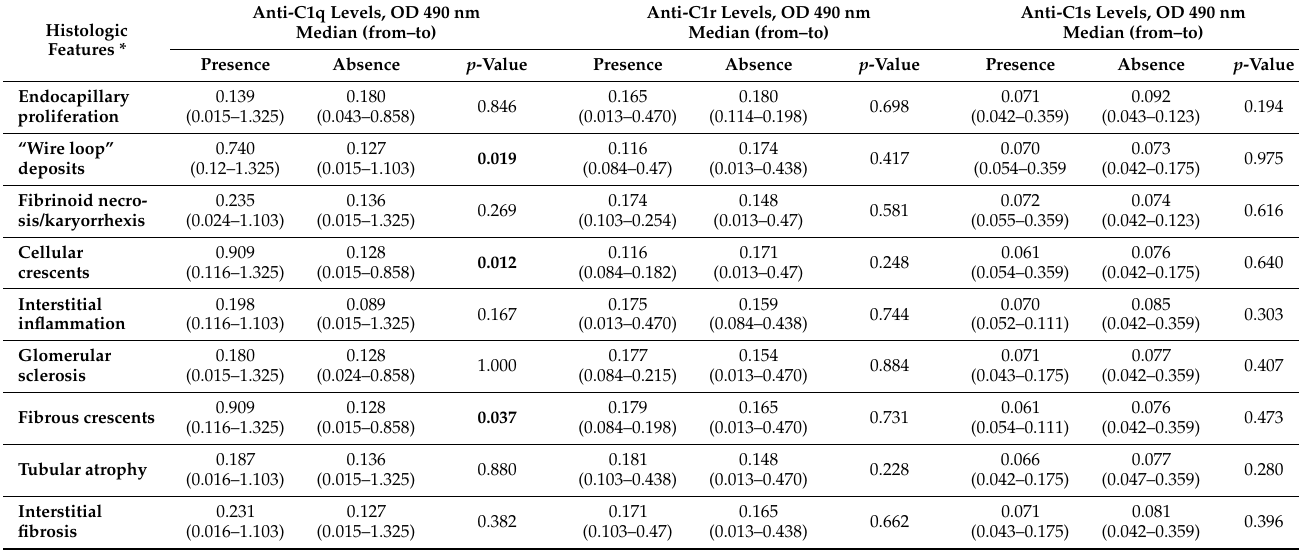
Figure 5. Association of the presence of anti-C1q antibodies in patients at the time of first sampling with the categories of the BILAG Renal score and histological signs of LN. Correlation between anti- C1q antibodies and categories of LN activity according to the BILAG Renal score ( A ). Comparative analysis between levels of anti-C1q antibodies in category A LN patients and patients classified into other categories according to the BILAG Renal score ( B ). ROC curve for anti-C1q antibodies in LN patients in BILAG category A towards LN patients in the rest of BILAG categories ( C ). Association between anti-C1q antibodies and histology class of LN ( D ). Correlation analysis between levels of anti-C1q antibodies and histological activity index ( E ) and histological chronicity index ( F ). Table 1. Comparative analysis between levels of anti-C1q, anti-C1r and anti-C1s in the groups with and without histological signs of LN activity and